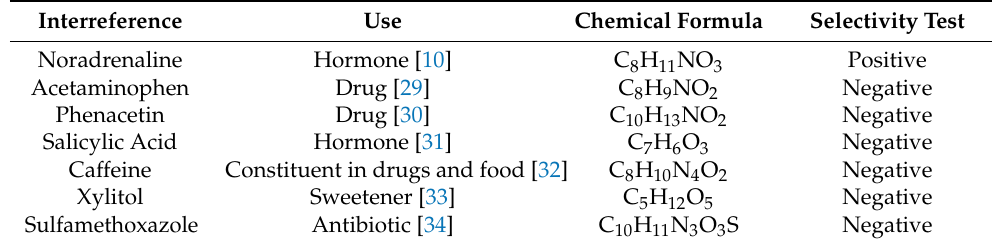
Table 2. The selectivity of the citrate-capped AuNPs against NA and possible interferences.